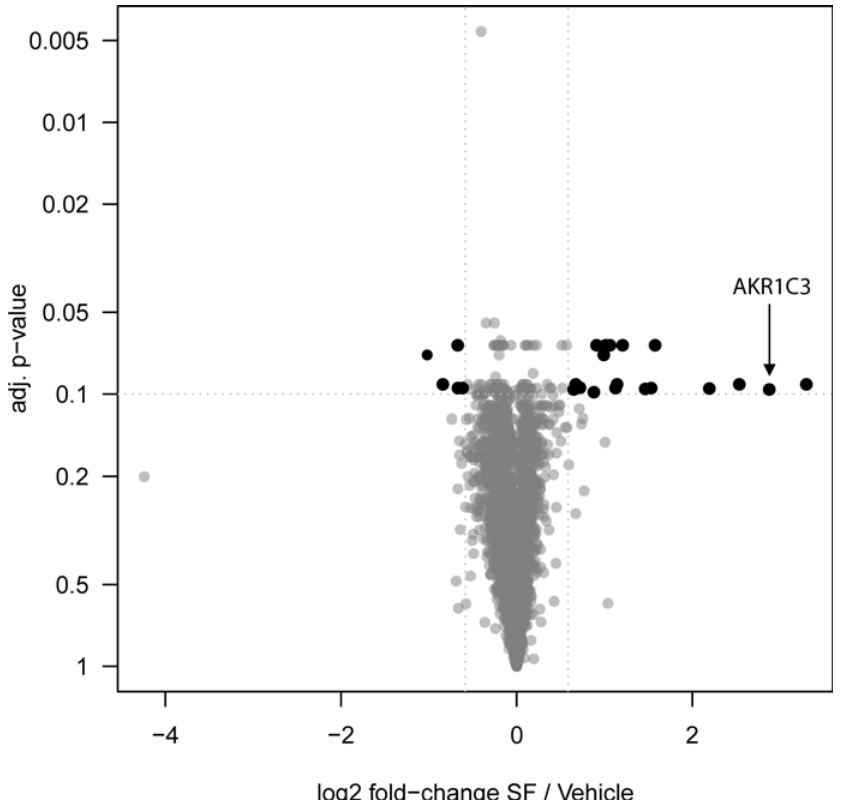
Fig 2. Volcano plot showing significant changes in the proteome following exposure of HT29 cells to 2.5 μ M SF for 48 h, determined by SILAC. 2653 proteins (black and gray) were quantified and tested for significance. Among the 23 significantly regulated proteins (black), 18 were up-regulated and 5 down- regulated in